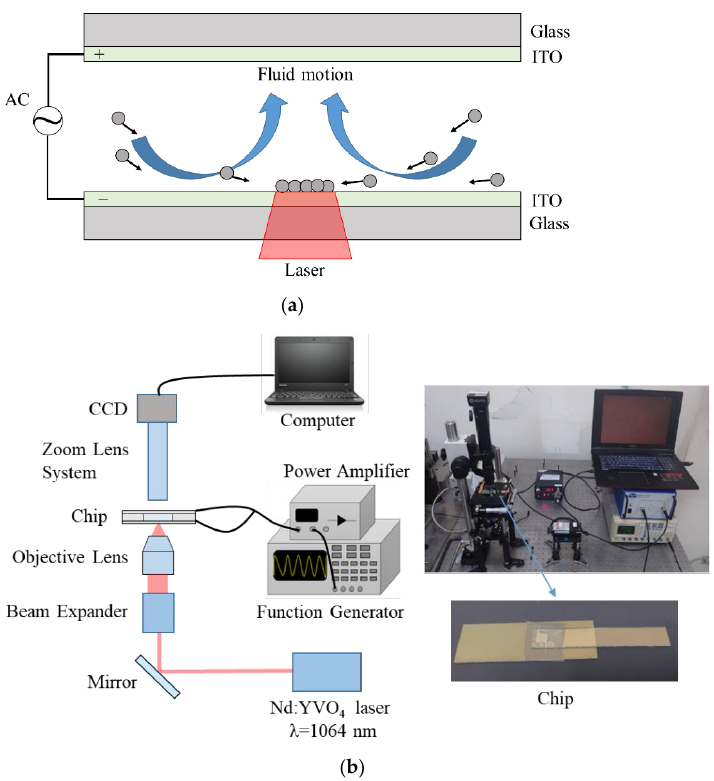
Figure 1. ( a ) Schematic illustration of REP chip. ( b ) Experimental setup and picture of optoelectro- kinetic platform.